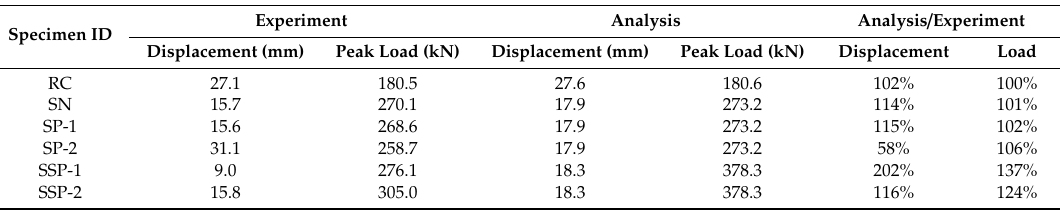
Table 7. Comparison of test data with analytical solutions.